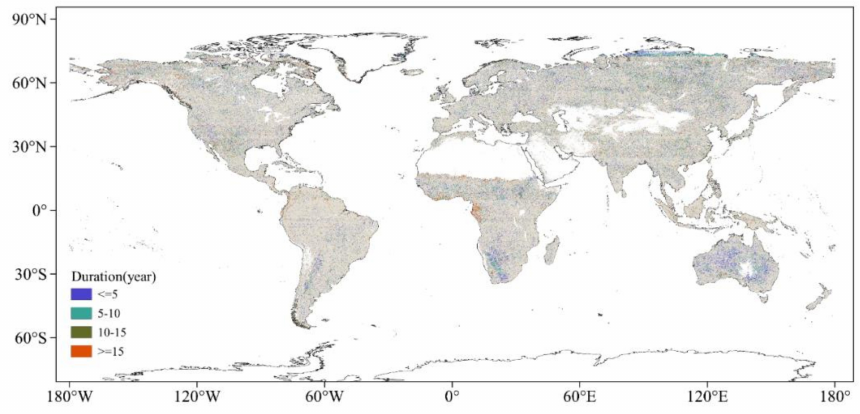
Figure 6. The spatial distribution of duration of the segmented change trends was discretely rendered at a 5-year interval. The unchanged area, together with the full-period segment of the trend, is shown in gray for better visualization.